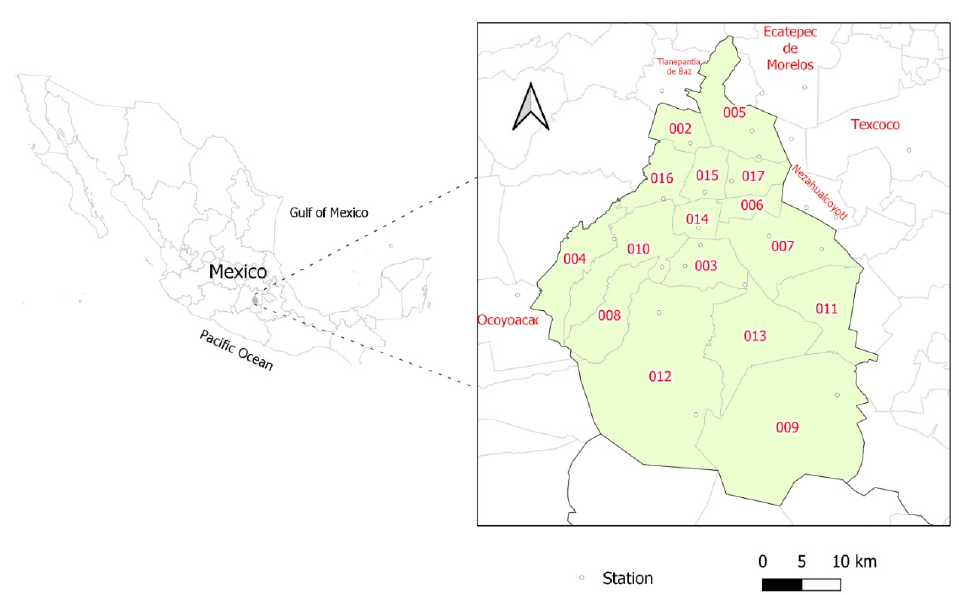
Figure 1. ( Left ): Mexico at the national level. ( Right ): Mexico city with Alcaldías. 002: Azcapotzalco, 003: Coyoacán, 004: Cuajimalpa de Morelos, 005: Gustavo A. Madero, 006: Iztacalco, 007: Izta- palapa, 008: La Magdalena Contreras, 009: Milpa Alta, 010: Álvaro Obregón, 011: Tláhuac, 012: Tlalpan, 013: Xochimilco, 014: Benito Juárez, 015: Cuauhtémoc, 016: Miguel Hidalgo, and 017: Venustiano